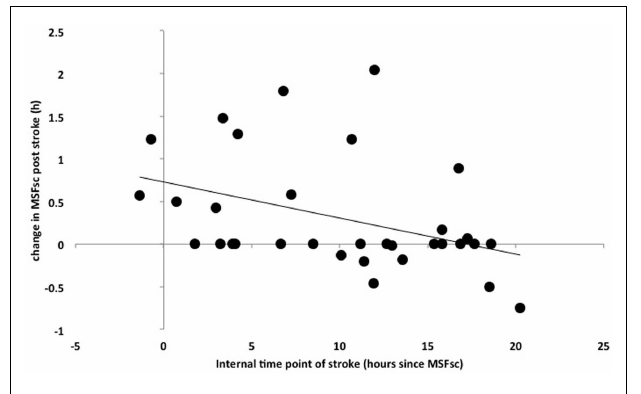
FIGURE 3 | Correlation between Int stroke (MSF sc-before-stroke − local time point of stroke) ( x -axis) and the difference in MSF sc after stroke (MSF sc-afterstroke − MSF sc-beforestroke ) ( y -axis) in 35 stroke patients (13 female) (Spearman correlation, R = 0.421, p = 0.015) .The correlation shows that the closer the time point of a stroke is to an individual’s MSF sc , the larger the advance (expressed as positive values on the y -axis) in chronotype (MSF sc ) after the stroke.